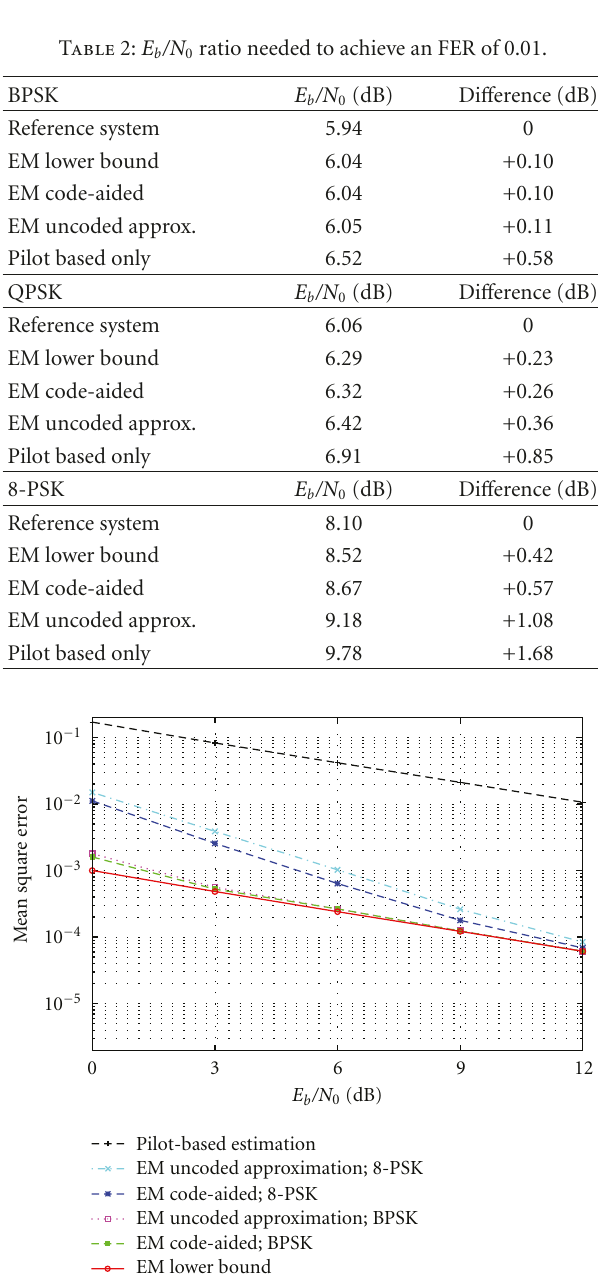
Figure 5: Mean Square Error values for the estimate of h 0